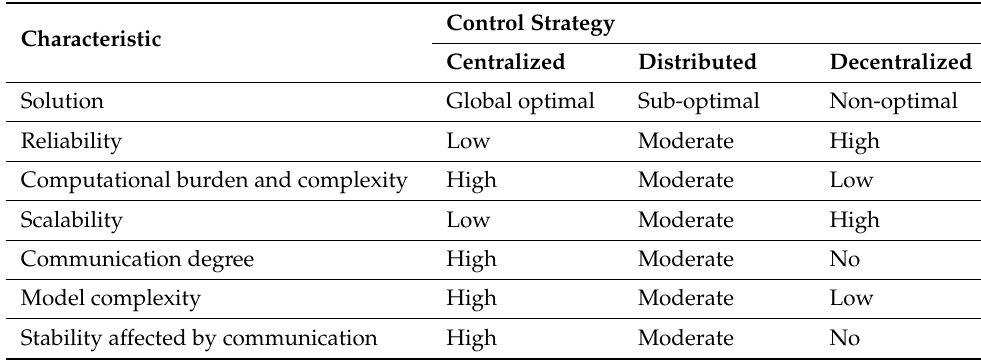
Table 8. Comparing the characteristics of different control